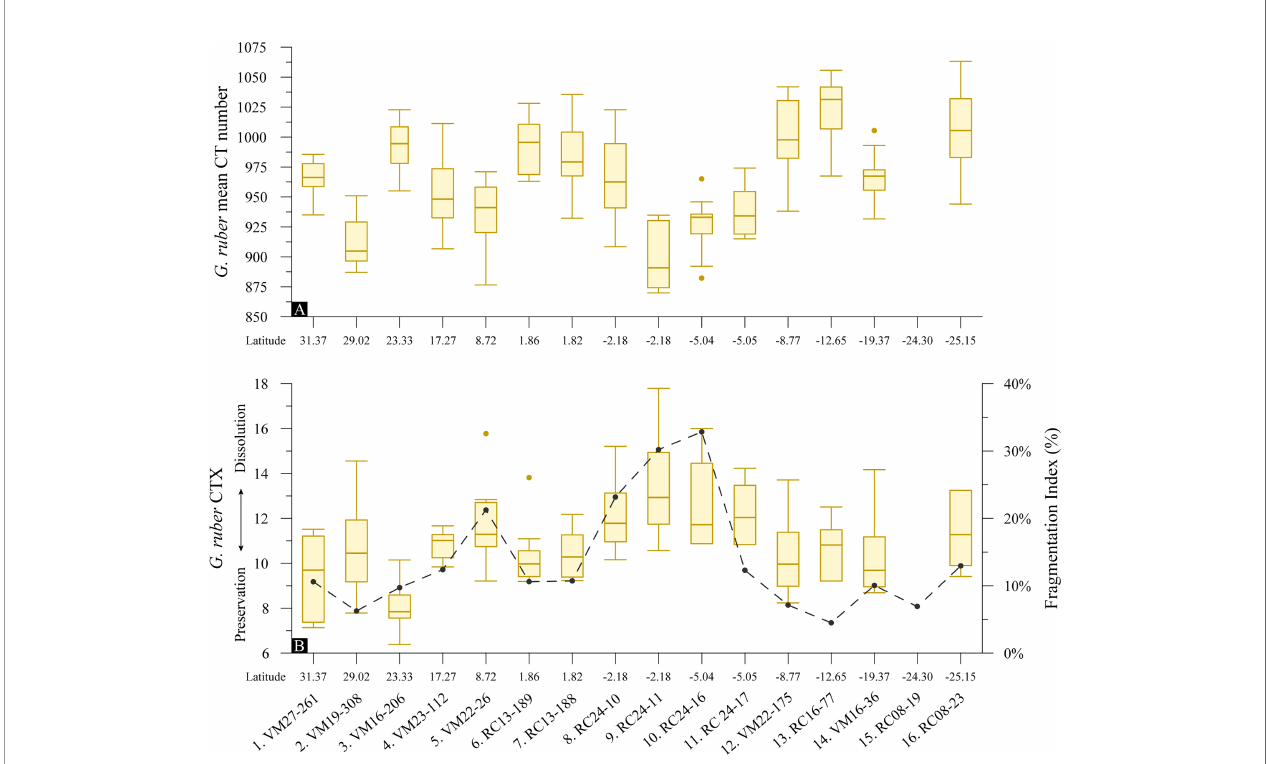
FIGURE 6 | Box-and-whisker plots of foraminifera test (A) mean CT number indication test relative densities and (B) CTX dissolution index of the specimens with latitude for G. ruber albus (n = 152) superimposed with the planktonic foraminifera Fragmentation Index. Boxes extend from the lower to upper quartile values of the data, with a line at the median. Whiskers indicate 1.5 times the inter-quartile distance. Dots are